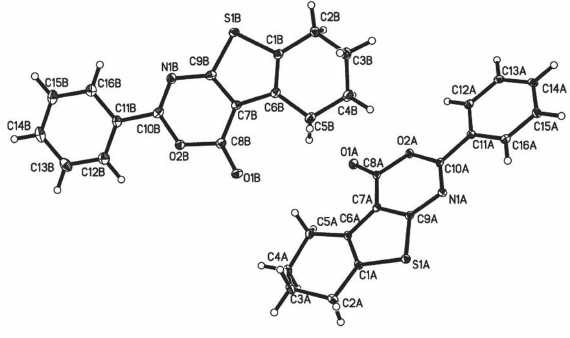
Table 1: Data collection and handling.